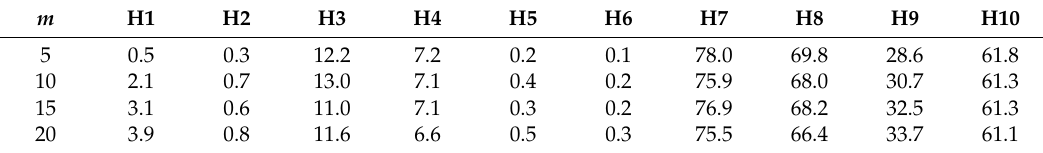
Table 8. Comparison of performances (RPD) of heuristics by number of machines for Group 2.